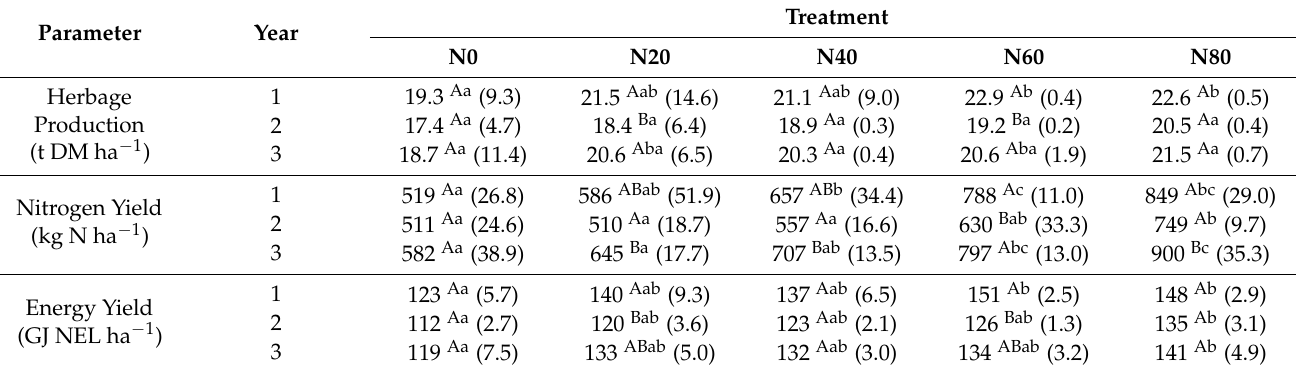
Table 2. Measured total herbage production (t DM ha − 1 ), nitrogen yield (kg N ha − 1 ) and energy yield (GJ NEL ha − 1 ) contents of the pasture herbage. The averages were calculated between the three experimental years for the different N fertilization treatments used (N0, N20, N40, N60 and N80). SEM are shown in